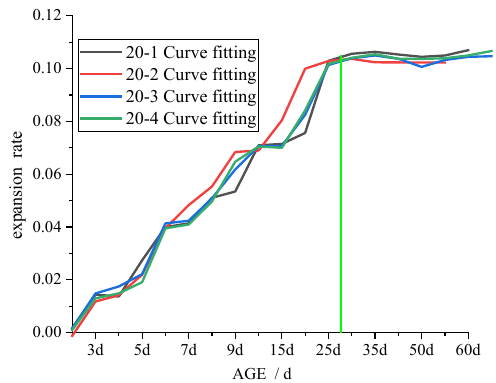
Figure 10. Curve of expansion rate and age of specimen with 20% binder.